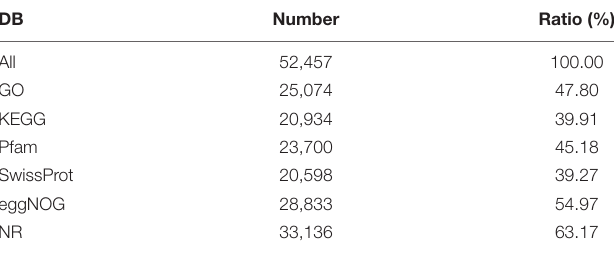
TABLE 2 | Statistical results from the DIAMOND 23 annotation.